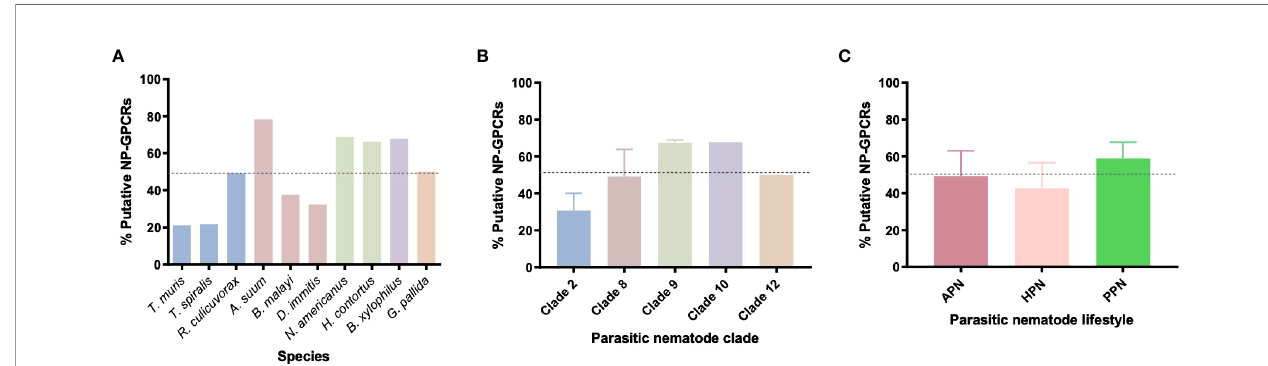
FIGURE 2 | Nematode parasites have reduced and variable NP-GPCR complements across (A) 10 nematode species (B) phylogenetic clades and (C) parasitic lifestyles, expressed as a % of the predicted 152 Caenorhabditis elegans NP-GPCRs. Dotted line represents the average % (49.3%) of Ce-NP-GPCRs across all 10 species. APN, animal parasitic nematode; HPN, human parasitic nematode; PPN, plant